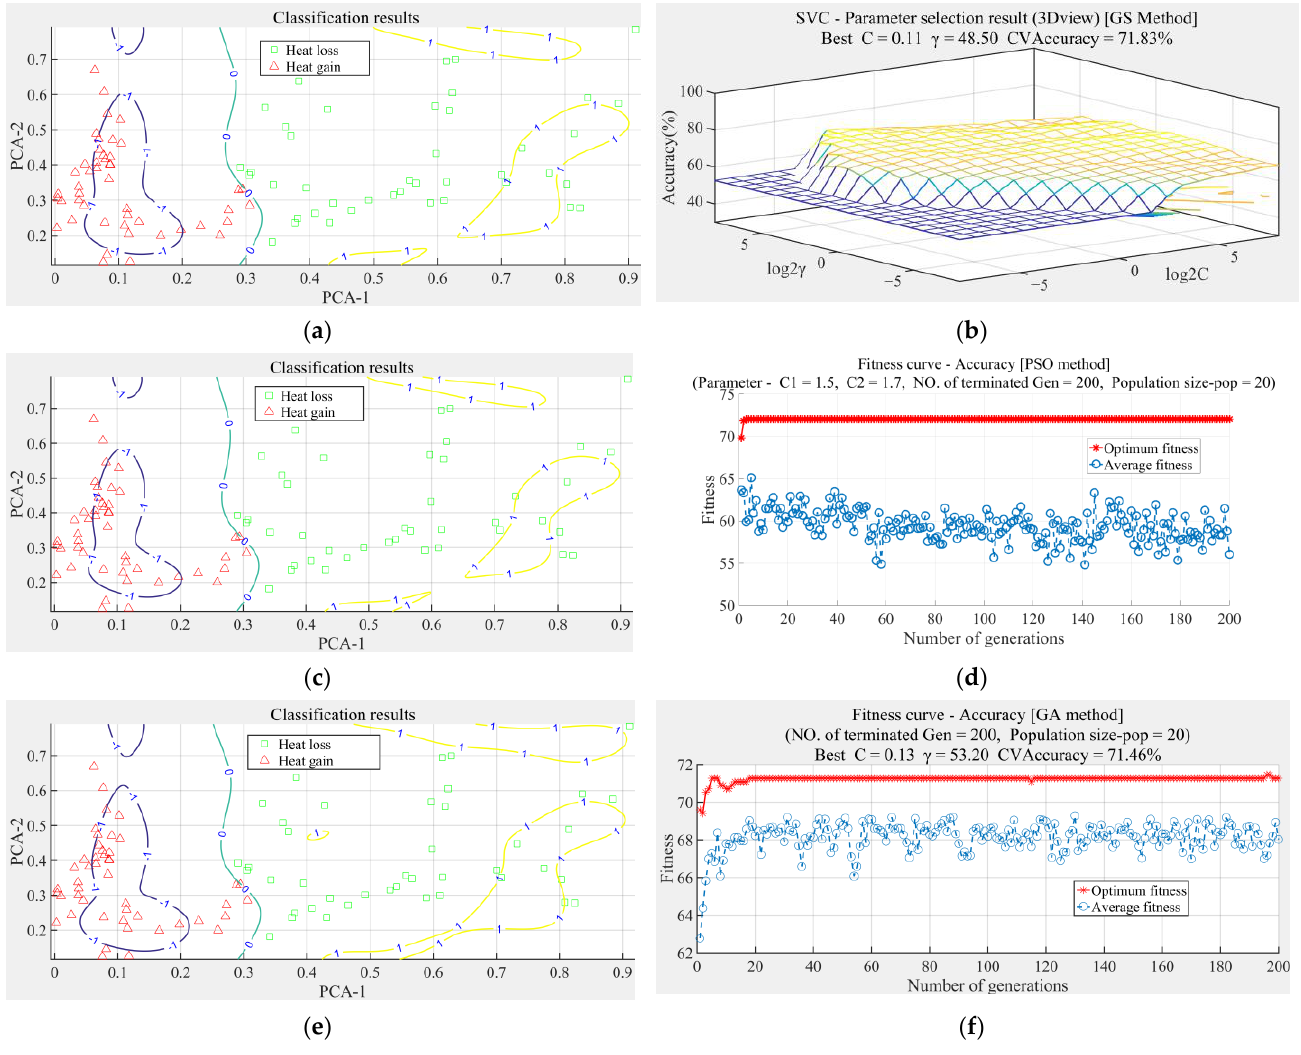
Figure 5. ( a ) the PCA-GS-SVM classification; ( b ) parameter optimization using the GS method; ( c ) the PCA-PSO-SVM classification; ( d ) the fitness curve of the PSO algorithm; ( e ) the PCA-GA-SVM classification; ( f ) the fitness curve of the GA algorithm. Table 3. The PCA-1~PCA-2 parameter values using different methods.